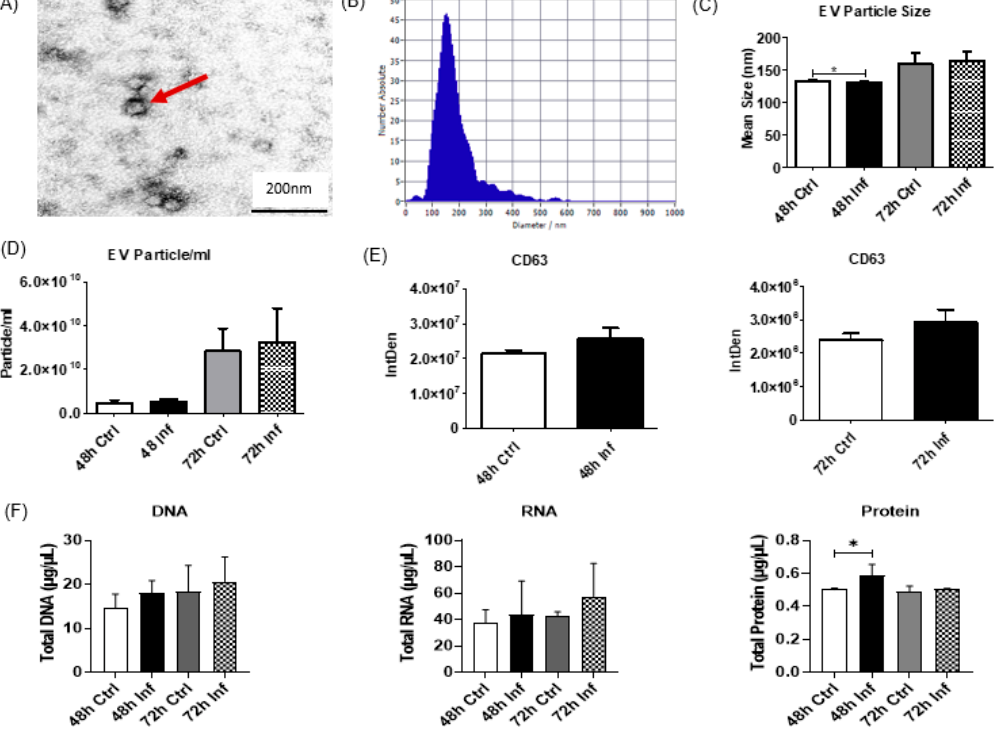
Figure 2. CRFK-derived extracellular vesicle (EV) characterization after CCoV infection. The morphology, size distribution (nm), and concentration (particles per mL) of CRFK-derived control EVs and infection EVs after CCoV infection were characterized. ( A ) transmission electron microscopy (TEM) images showing morphologies of CRFK-derived control sEVs at 48 h (small EVs indicated by red arrow); ( B ) nanosight particle tracking analysis (NTA) showing size distribution pattern of CRFK-derived EVs; ( C ) mean particle size; ( D ) particle concentration per mL, at 48 h and 72 h; ( E ) graphs showing densitometric analysis of dot blot (Supplementary Figure S2A) of classical EV biomarker, cluster of differentiation (CD)63, via Bio-Rad imaging program and GraphPad Version 5 software in isolated EVs at 48 h and 72 h; ( F ) total DNA, RNA, and protein content of CCoV-infected CRFK-derived control and infected EVs at 48 h and 72 h. Statistical analysis of obtained data points was performed using one-way ANOVA with Tukey post hoc analysis. Statistical significance is indicated by the mean ± SD and is defined as p ≤ 0.05